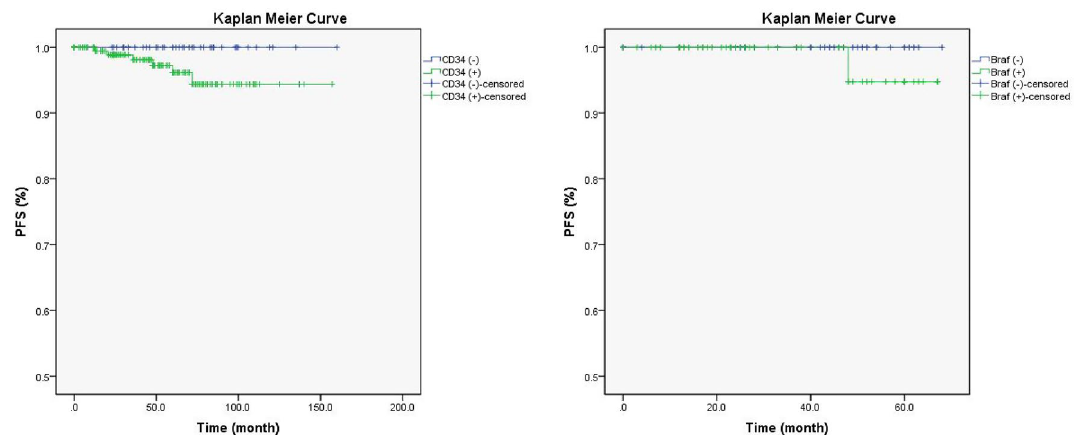
Figure 2. The comparison of Kaplan–Meier curves of CD34 expression and BRAF V600E mutation in glioneuronal tumors with